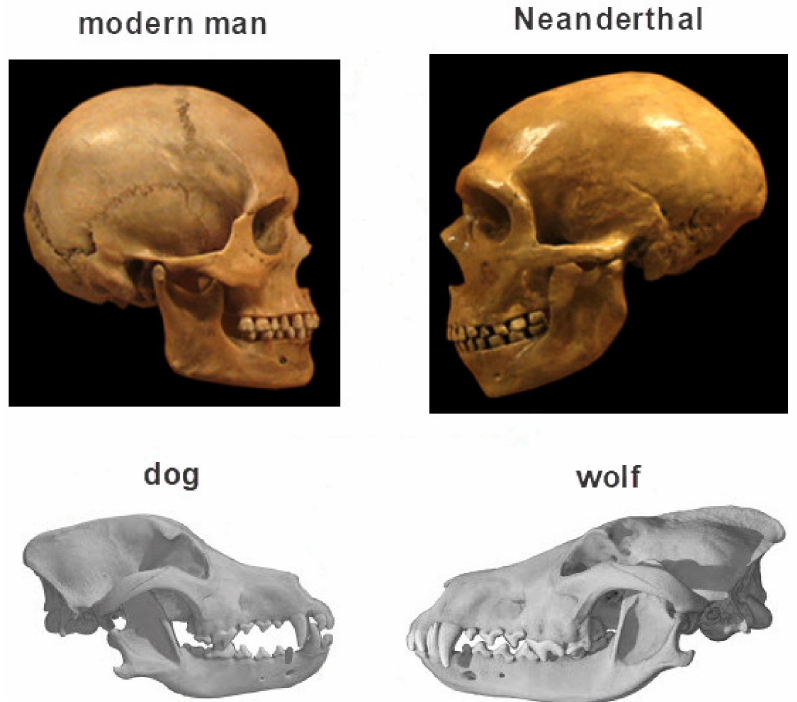
Figure 5. Comparison of dog domestication and human self-domestication. Illustration modified from Theofanopoulou et al. (2017) [45]. Photographs of the skull of modern man ( Homo sapiens ) and prehistoric man ( Homo neandertalensis ) are from commons.wikimedia.org. Similar to differences between dog and wolf, note that the skull of modern man is much more neotenic compared to the skull of a Neanderthal (smaller skull and brain, oval forehead, less protruded nasal bone, smaller teeth, orthognathia), which can be said to be